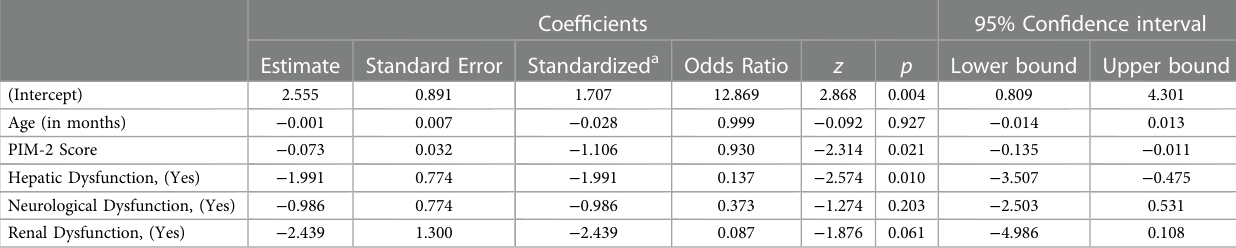
TABLE 4 Multivariate logistic regression analysis for independent predictor for